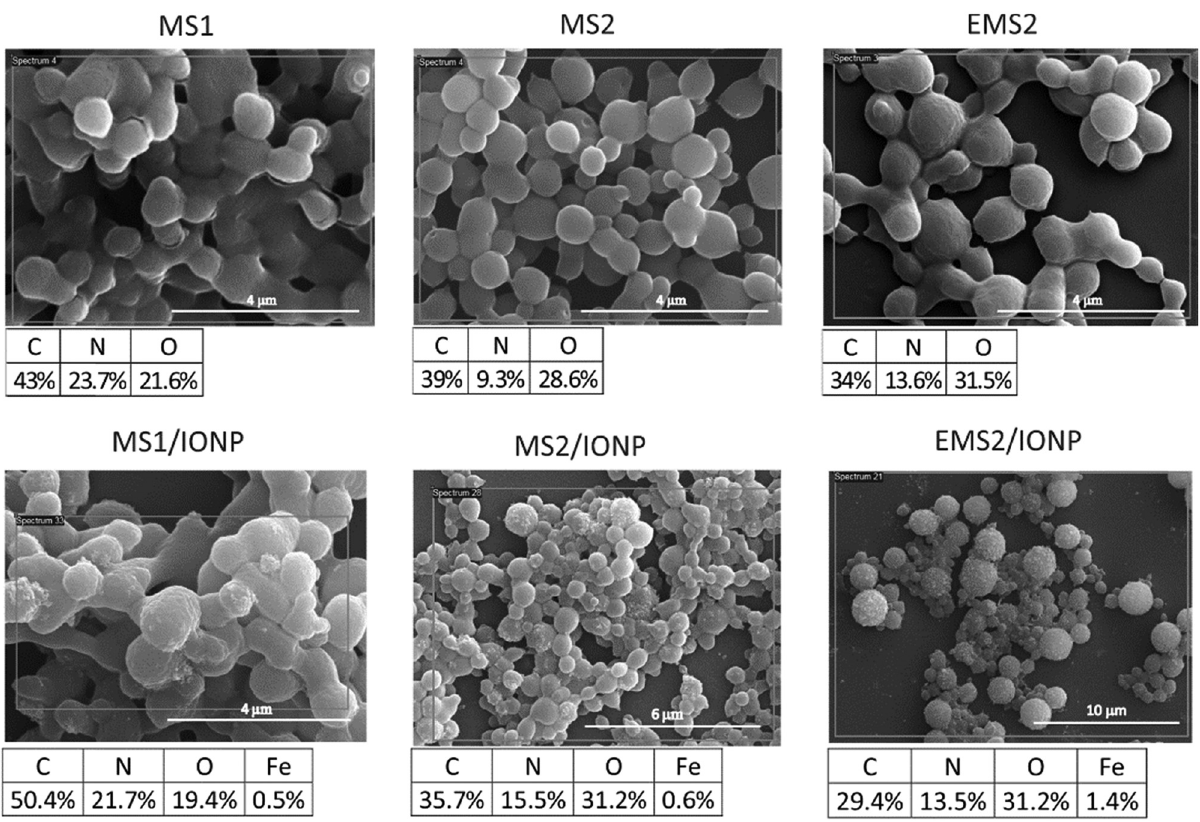
Figure 6: SEM images and EDXS quantitative results of the selected elements of MS1 and MS1/IONP spheres, MS2 and MS2/IONP spheres, and EMS2 and EMS2/IONP spheres ( 83 ) . Copyright 2019,